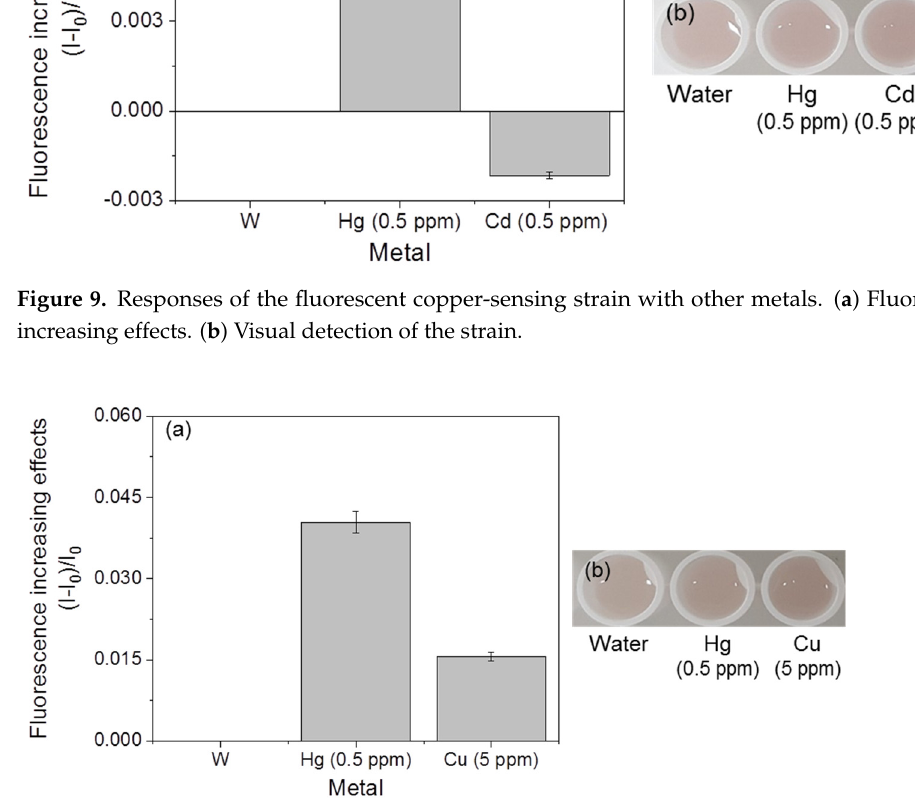
Figure 10. Reaction of the fluorescent cadmium-sensing strain with other metals. ( a ) Fluorescent increasing effect. ( b ) visualization of the fluorescent signal.